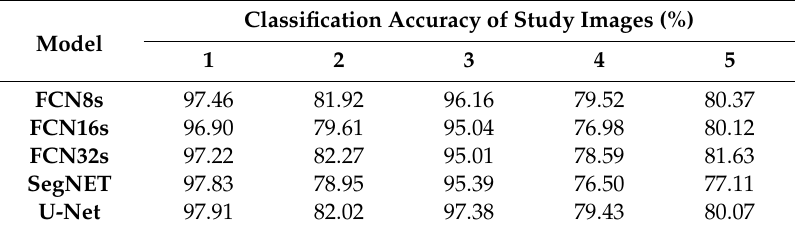
Table 2. Classification accuracy for the study